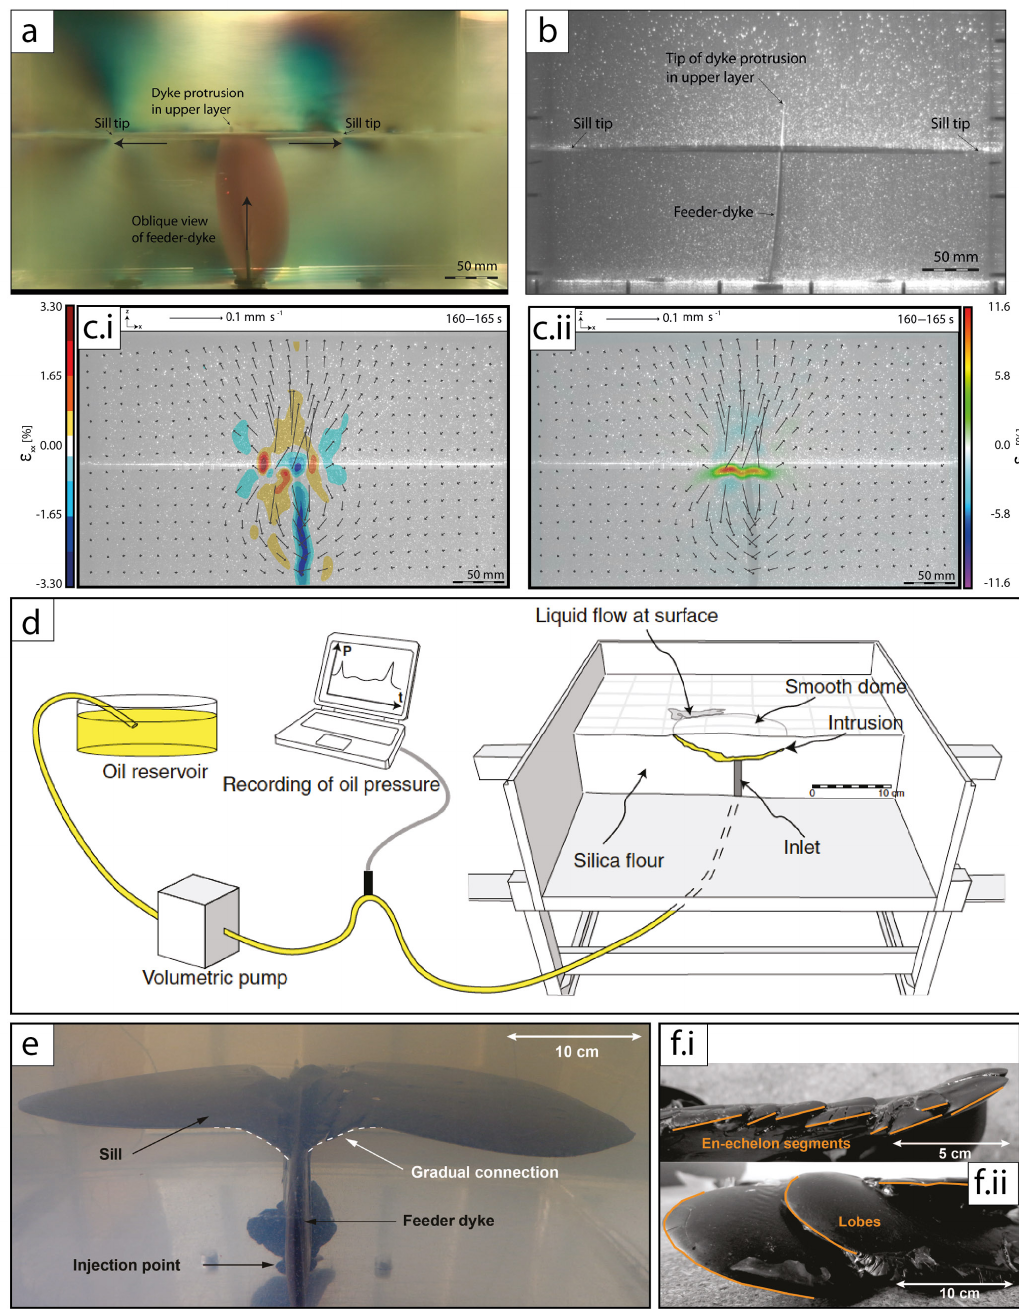
Figure 10. Analogue experiments studying sill formation. (a–b) Dyke–sill hybrid formation from a feeder dyke in layered gelatine along a weak interface (Kavanagh et al., 2017): (a) polarised light enables stress to be visualised through coloured fringes and (b) a laser-illuminated vertical section through the experiment, showing the sharp boundary between intrusion and host. (c) Digital image correlation of sill formation from a feeder dyke in layered gelatine (Kavanagh et al., 2015). Colours indicate incremental strain in the gelatine, and arrows are displacement vectors at the moment of sill formation: (i) horizontal incremental strain and (ii) vertical incremental strain. (d) Experimental set-up in which Vegetaline is injected into compacted silica flour to model sheet intrusions (Galland et al., 2014). (e–f) Experimental sill formed from a feeder dyke in layered gelatine for which solidification effects are considered (Chanceaux, 2013); (e) typical sill-forming experiment and (f) excavated 3-D morphology of Vegetaline sill showing lobed and segmented propagation front (see also Chanceaux and Menand, 2014,